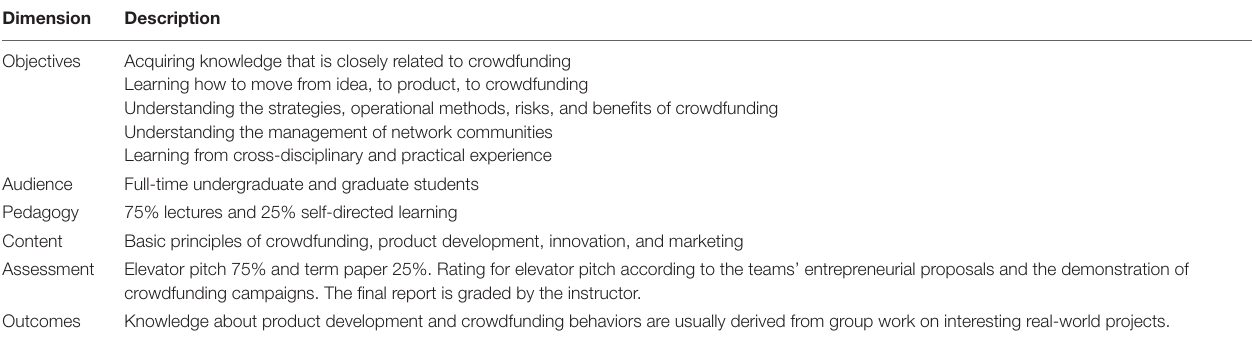
TABLE 1 | The components of a crowdfunding education program.